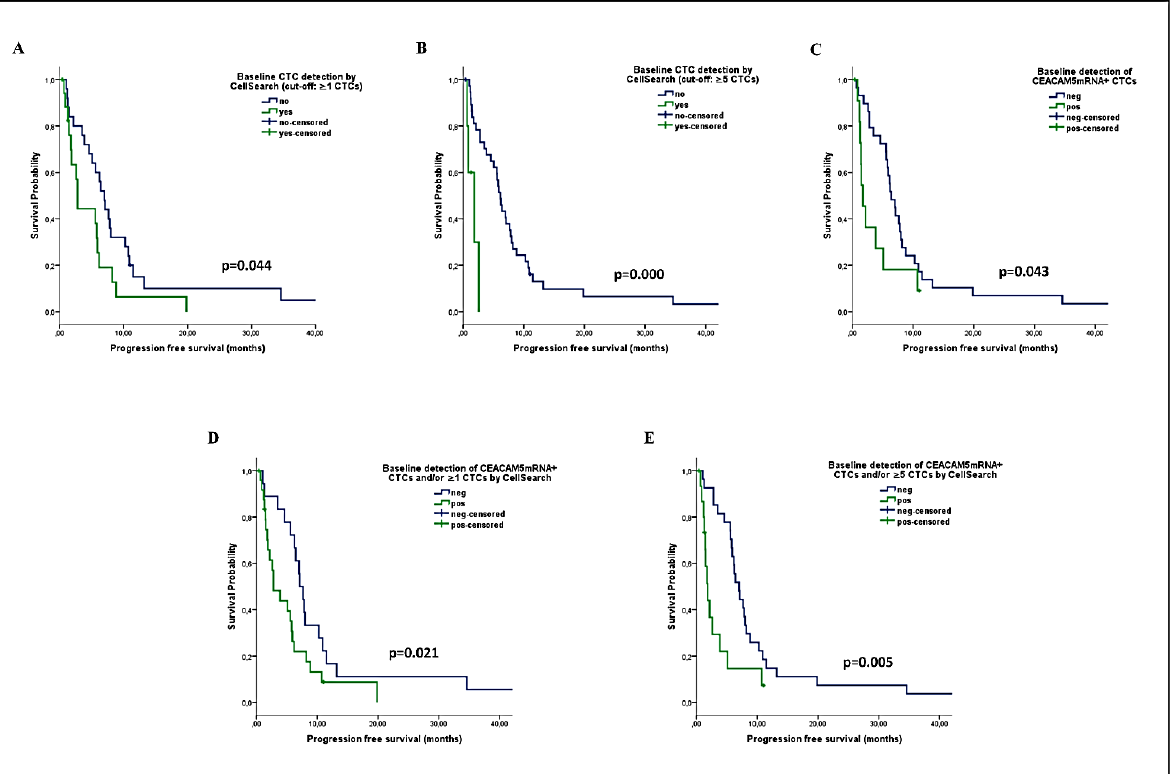
Figure 3. Progression-free survival (PFS) analysis among patients with NSCLC undergoing first-line chemotherapy, according to the baseline detection of CTCs by using the CellSearch or the CEACAM5 mRNA assay ( A – C ) or by their combination ( D , E